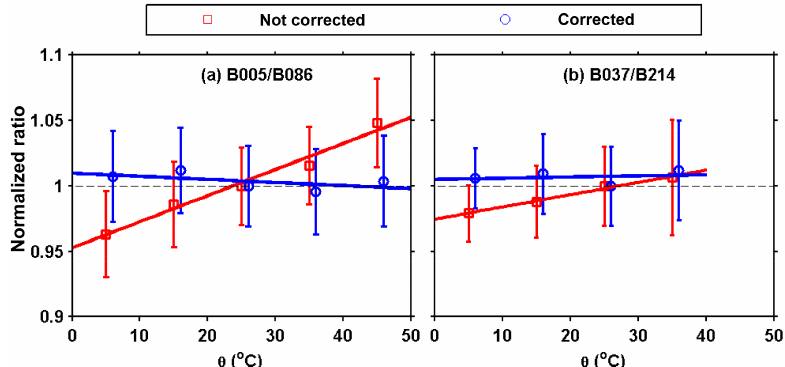
Figure 6. Ratio of the 300–325nm irradiance integrals derived for each pair of Brewers as a function of temperature before and after applying a temperature correction for (a) B005 and B086 in Thessaloniki and (b) B037 and B214 in Sodankylä. The ratios have been normalized to the mean ratio at 25 ◦ C. The error bars represent the 1 σ standard deviation of the mean for each 10 ◦ C bin.